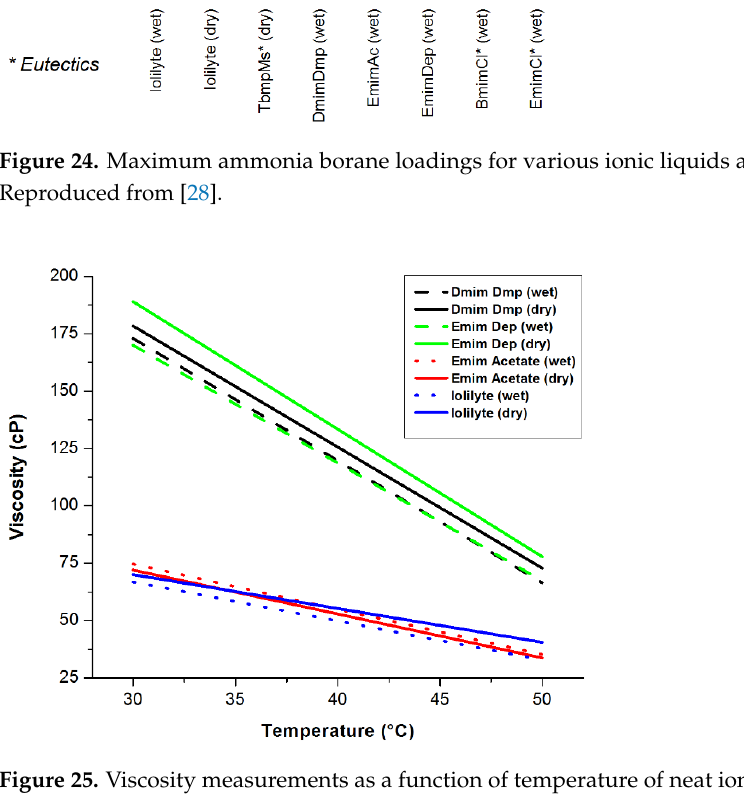
Figure 24. Maximum ammonia borane loadings for various ionic liquids and binary ionic liquids. Reproduced from [28].